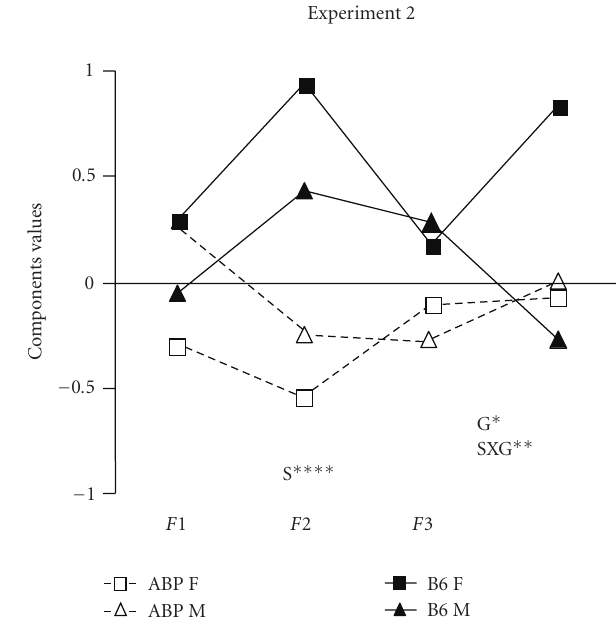
Figure 2: Mean scores by strain and gender of component values, S = strain e ff ect; G = gender e ff ect; SXG = strain-gender interaction, ∗ = P < . 04; ∗∗ = P < . 01; ∗∗∗∗ = P < .